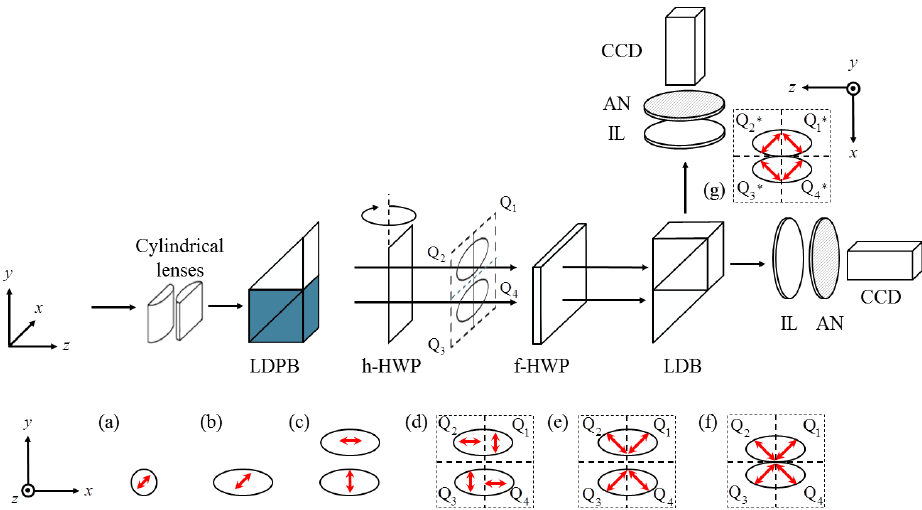
Figure 1. Schematic representation of the generation of radially and azimuthally polarized beams. The diagrams illustrate the cross-section of the laser beam and the associated states of polarizations caused by passing through ( a ) the laser; ( b ) a pair of cylindrical lenses; ( c ) the lateral displacement polarizing beamsplitter (LDPB); ( d ) the half-size half-wave plate (h-HWP); ( e ) the full-size half-wave plate (f-HWP); ( f ) the lateral displacement beamsplitter (LDB); and by reflecting off ( g ) the LDB. The coherent superposition of orthogonal polarizations in the far field is achieved with a positive imaging lens (IL) and the beam profiles are checked using an analyzer (AN) and a charge-coupled device (CCD)